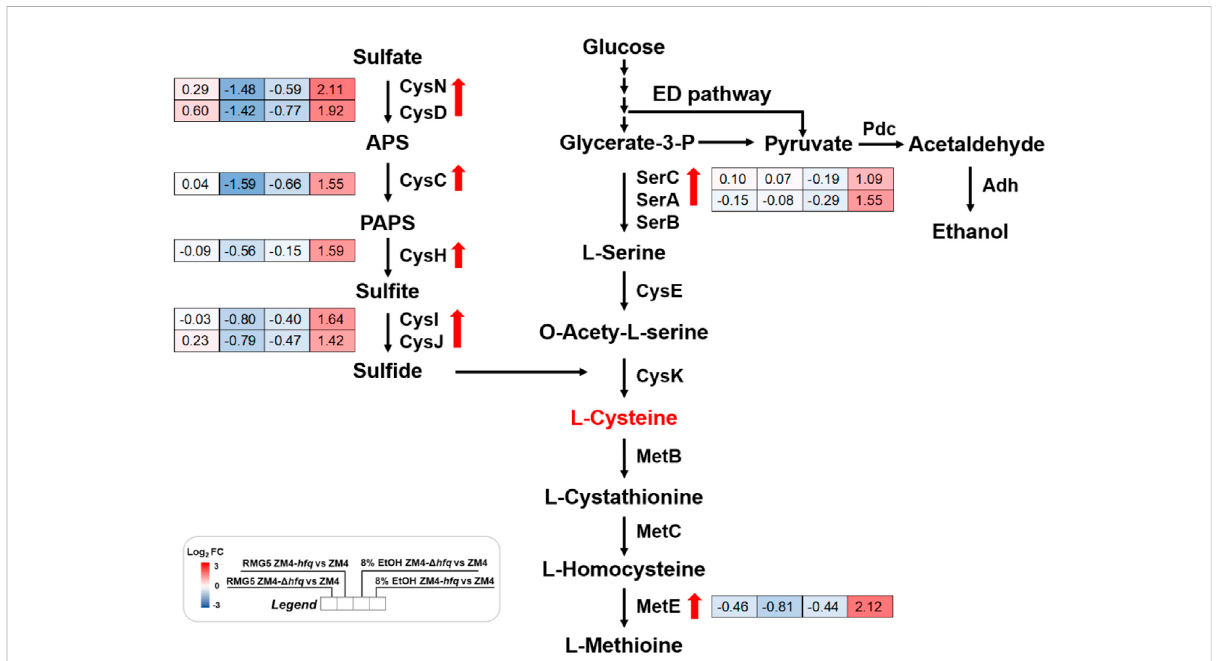
FIGURE 2 Transcriptionalchangesof genesinvolved inthesulfate assimilation andcysteine biosynthesisin Z.mobilis culturedindifferentconditions. Red and blue in the gene expression represent up-regulation and down-regulation respectively. Red arrows indicate the genes were signi fi cantly upregulated in ZM4- hfq compared with ZM4. APS: adenosine 5 ′ -phosphosulfate, PAPS: 3 ′ -phosphoadenylyl